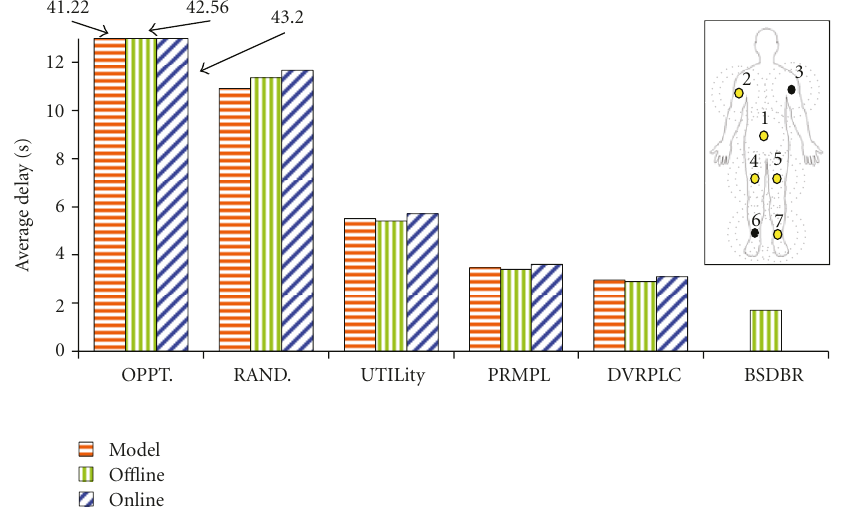
Figure 9: On-body packet delivery delay for di ff erent DTN routing protocols.